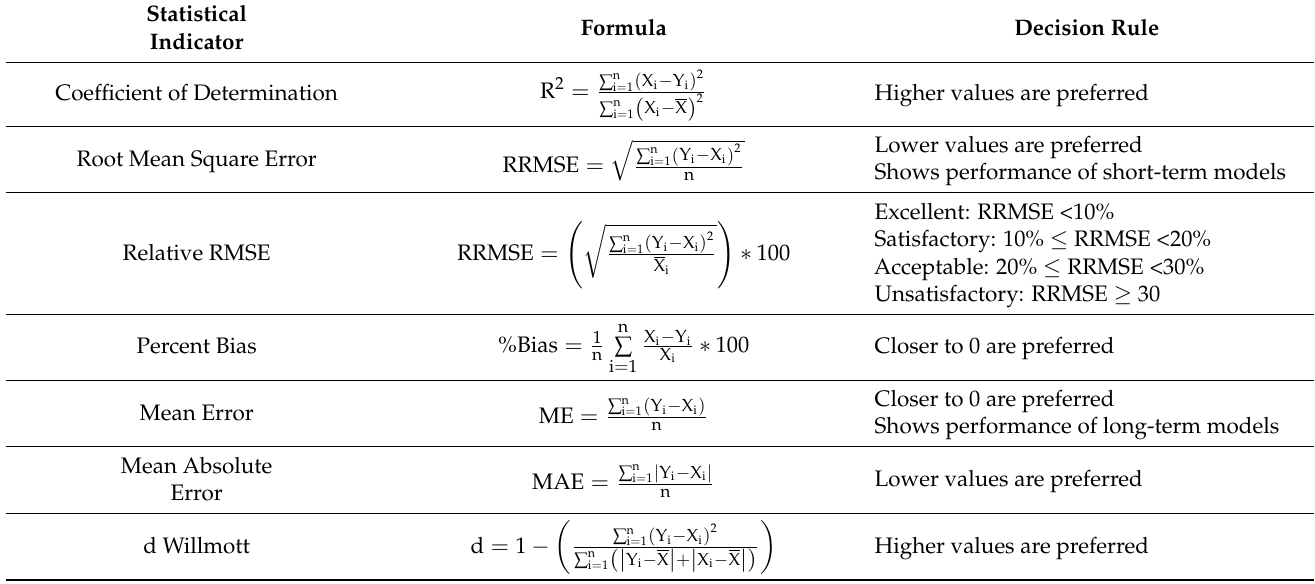
Table 4. Statistical indicators used for the performance evaluation of machine learning and empirical